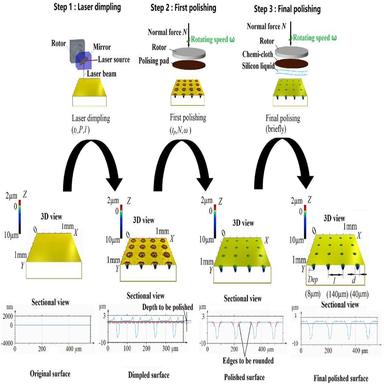
Processing scheme for manufacturing the textured surface.